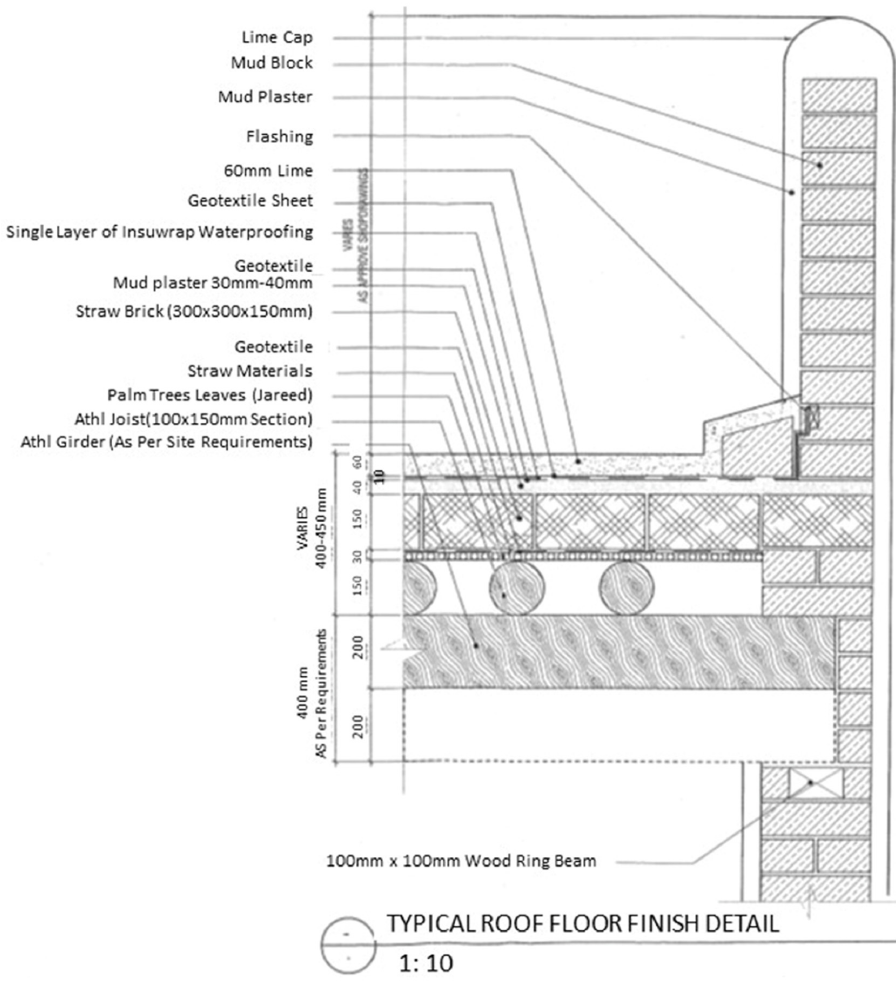
Figure 11. Long palm trees shaded the traditional house in Hail city.